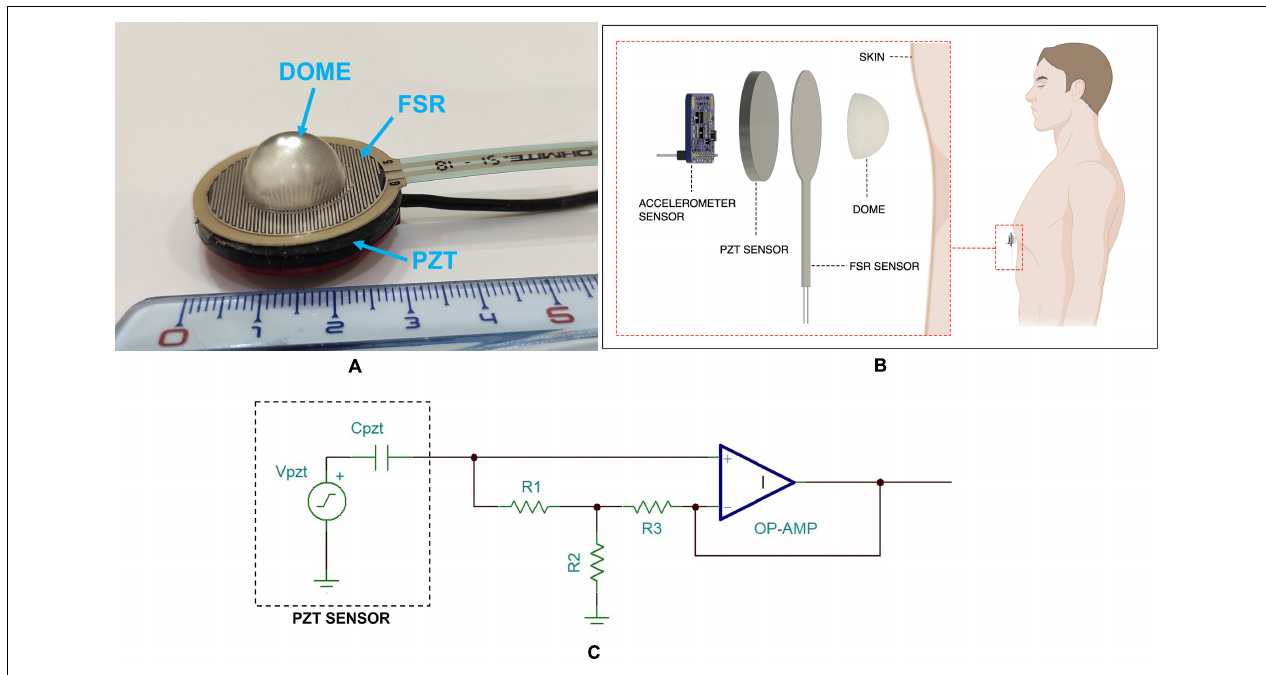
FIGURE 2 | Example of FCG sensor placement onto the chest of a subject by means of medical adhesive tape.